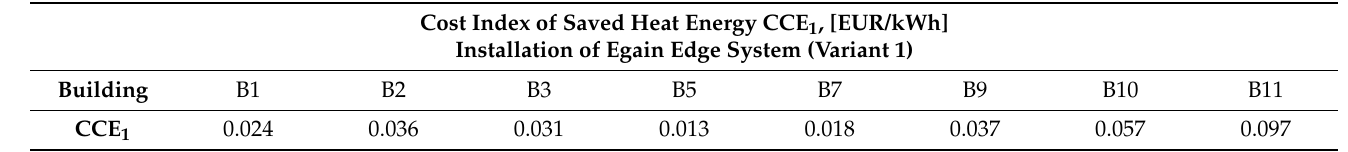
Table 16. Value of cost index of saved thermal energy after installation of Egain Edge system in buildings before thermal improvement CCE 1 [EUR/kWh].